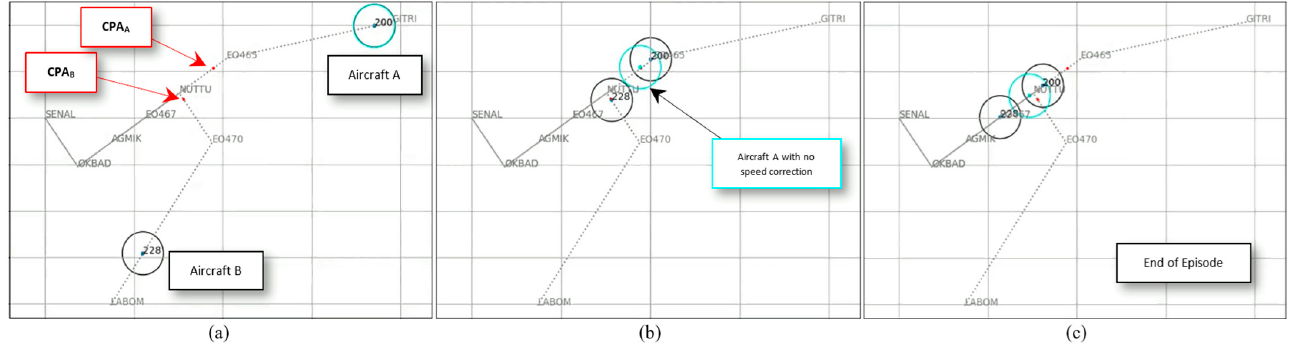
Figure 5. An example of the trained agent within the training scenario: ( a ) conflict detection and speed reduction; ( b ) conflict is correctly solved; ( c ) end of episode.